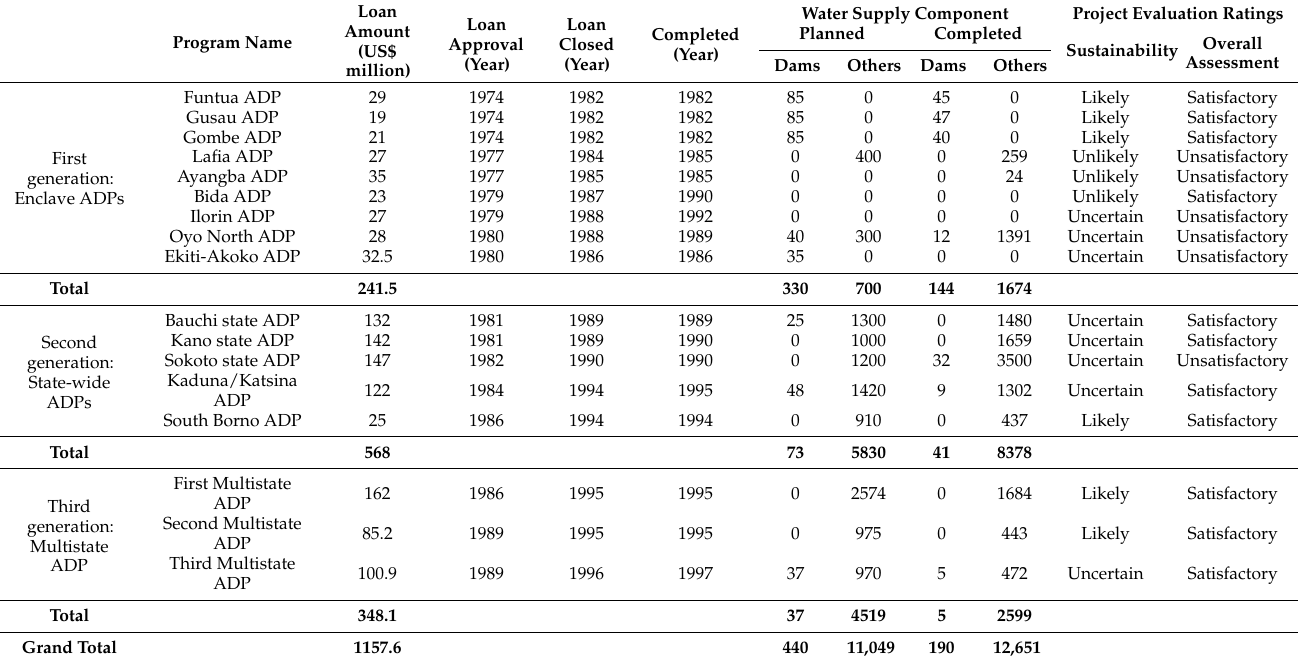
Table A4. The World Bank Agricultural Development Programs. Source: Authors.